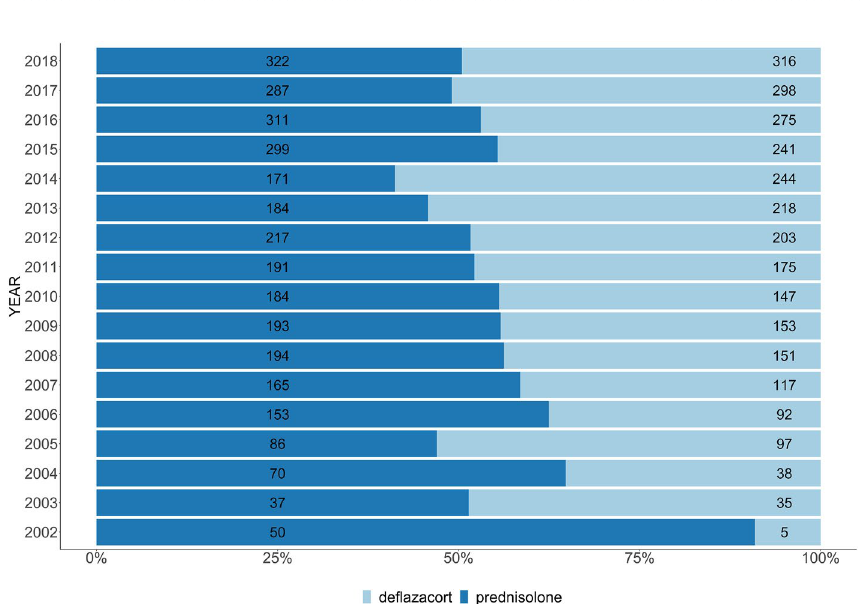
Figure 2. Corticosteroid use in South Korea based on the National Health Information Database.